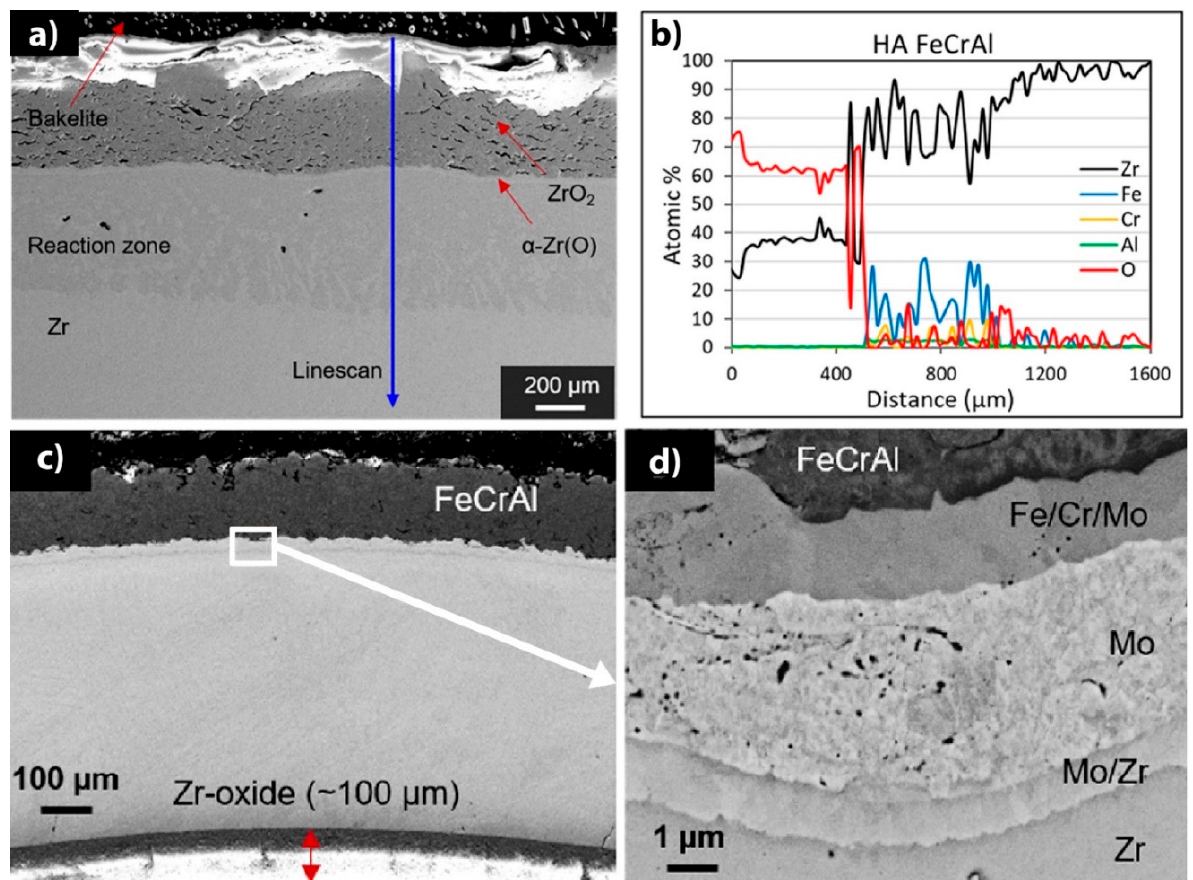
Figure 3. Cross-section SEM images after 1200 °C air oxidation: ( a ) FeCrAl-coated Zircaloy-4 and ( b ) corresponding EDS line scan; ( c ) FeCrAl/Mo coating and ( d ) magnified image of the FeCrAl/Mo/Zr interface. Reproduced from [84] with permission by Elsevier.